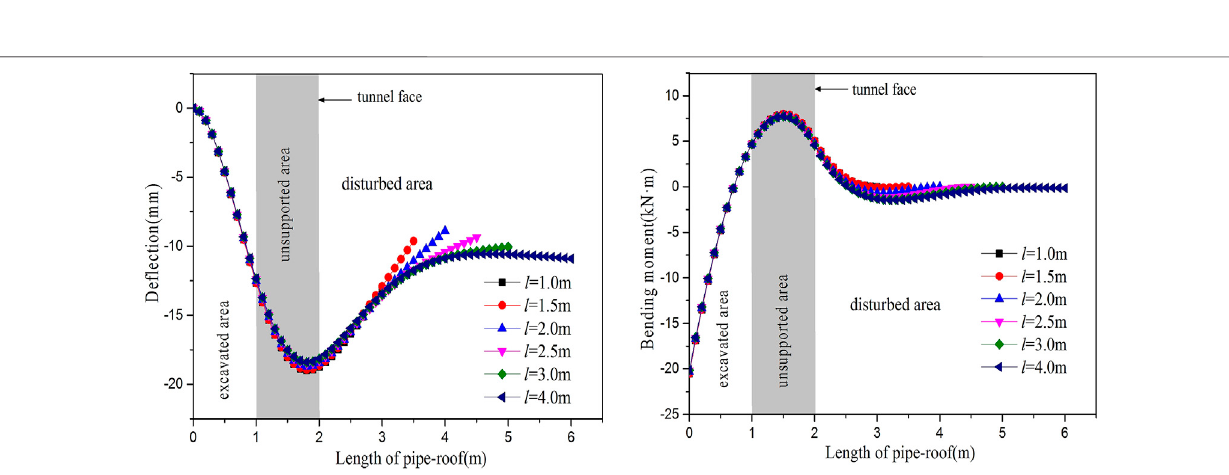
Frontiers in Earth Science |